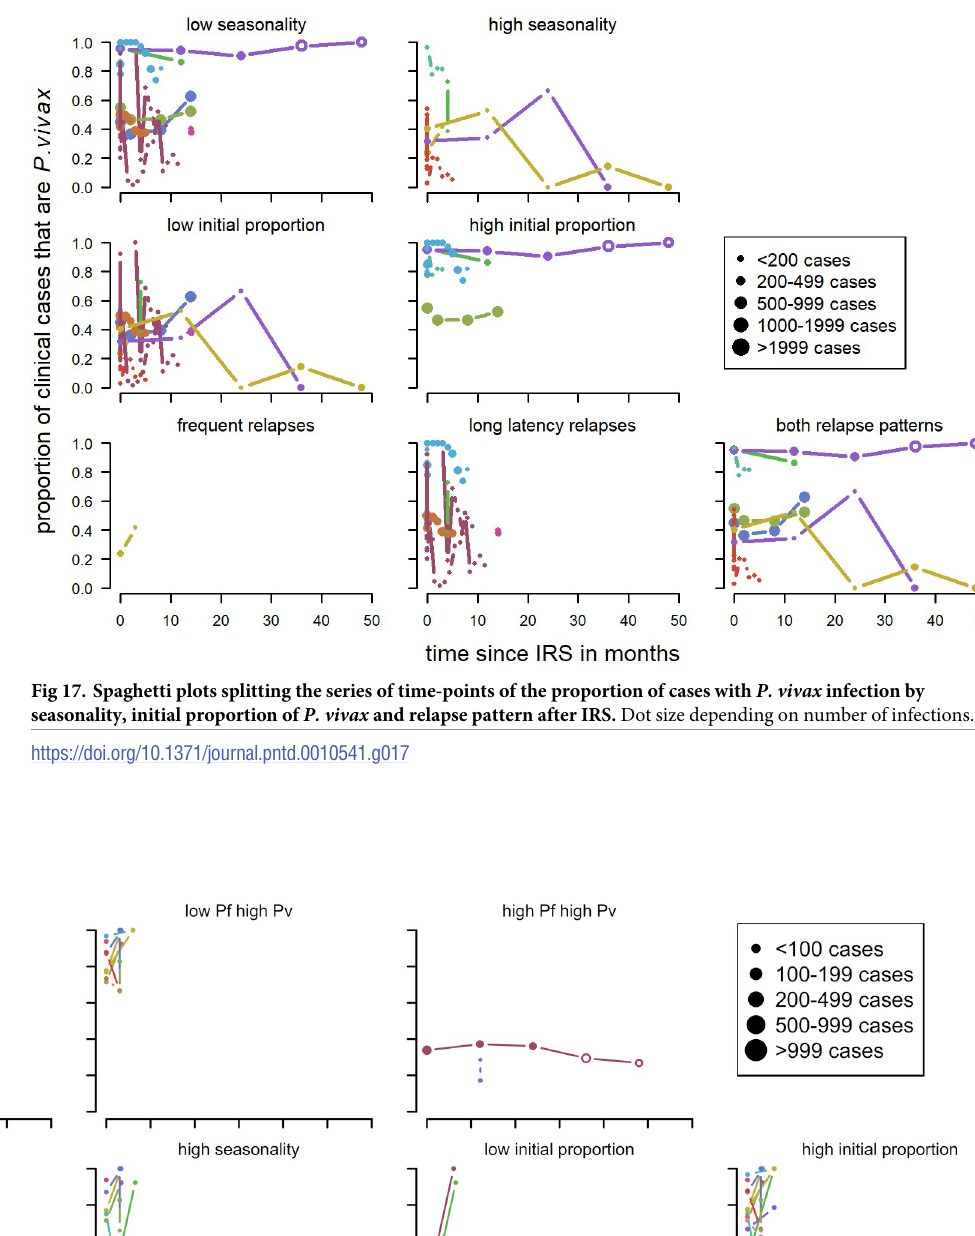
PLOS NeglectedTropical Diseases | https://doi.org/10.1371/journal.pntd.0010541 June 29,